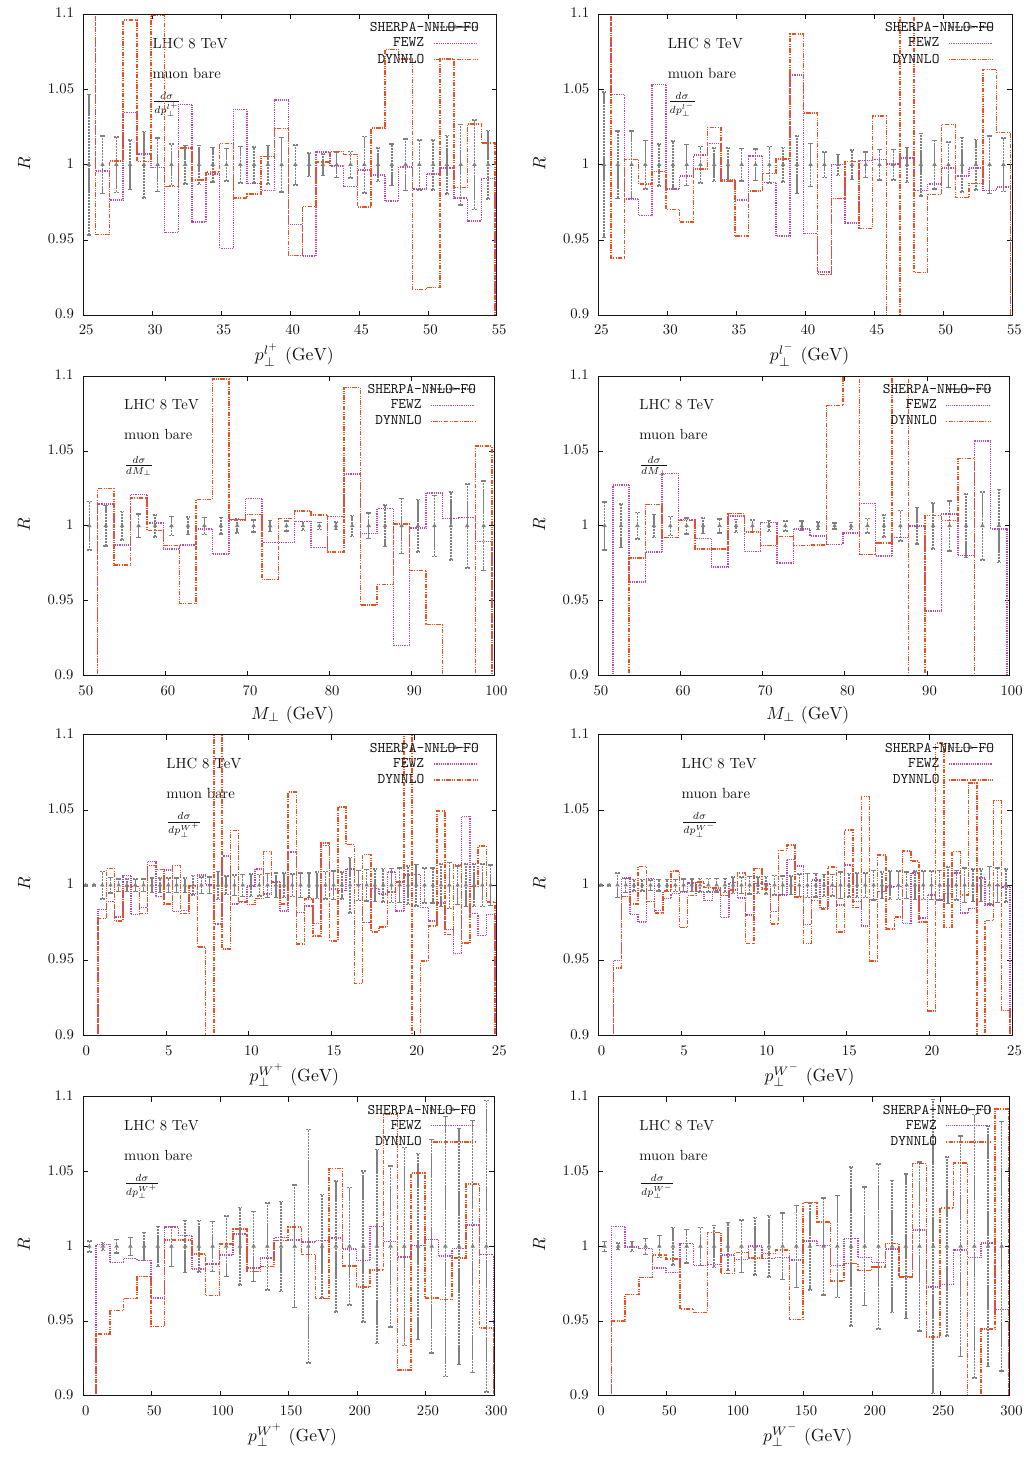
Fig. 15 Comparison of NNLO QCD predictions by DYNNLO , FEWZ and SHERPA-NNLO-FO for pp → W ± → μ ± ν μ + X for μ + ν μ ( left plots ) and μ − ¯ ν μ ( right plots ) final states. Comparison of the lepton